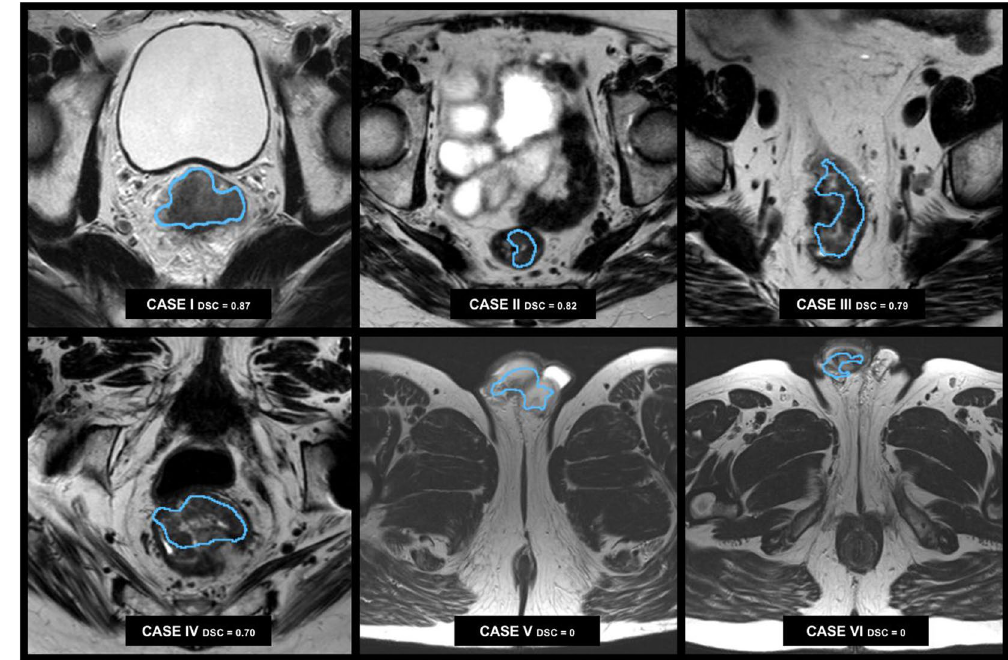
Figure 4. Example cases. Six example cases of the segmentation performed by the CNN. The algorithm correctly localized and segmented the tumour in case I to IV (small FOV images), but failed in cases with larger FOVs (cases V and VI) where parts of the cavernous bodies of the penis were erroneously included in these